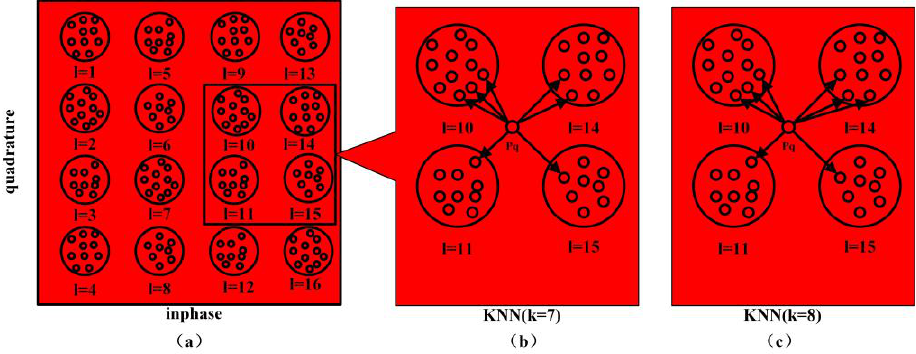
Fig. 2. Schematic diagram of KNN equalization 16QAM signal. (a) 16QAM signal constellation; (b) p when k=7; (c) Classification of Classification of q